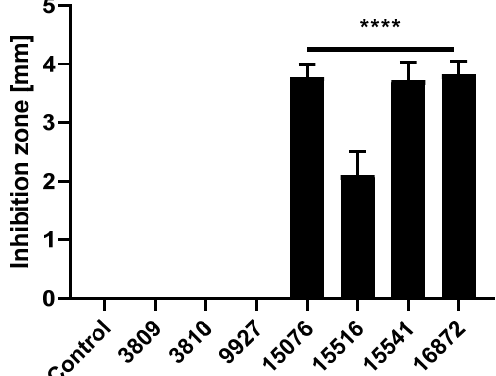
Figure 1. Agar well diffusion-based inhibition of pathogenic growth by seven Bacillus spp. strains. Seven Bacillus spp. strains (CHCC 3809, CHCC 3810, CHCC 9927, CHCC 15076, CHCC 15516, CHCC 15541, and CHCC 16872) were spotted on agar plates casted with Escherichia coli (ETEC) F4. Inhibition zones were measured after 24 h of incubation. Data are depicted as the width of the well (3.5 mm) subtracted from the diameter of the inhibition zone. Data are expressed as mean ± standard deviation (SD) of two experiments performed in triplicates or quadruplicates. One-way ANOVA and multiple comparison Dunnett’s tests were performed to assess statistically significant differences between the negative control group (with no inhibition zone) and other probiotic treatments. p -value ≤ 0.0001 (****).